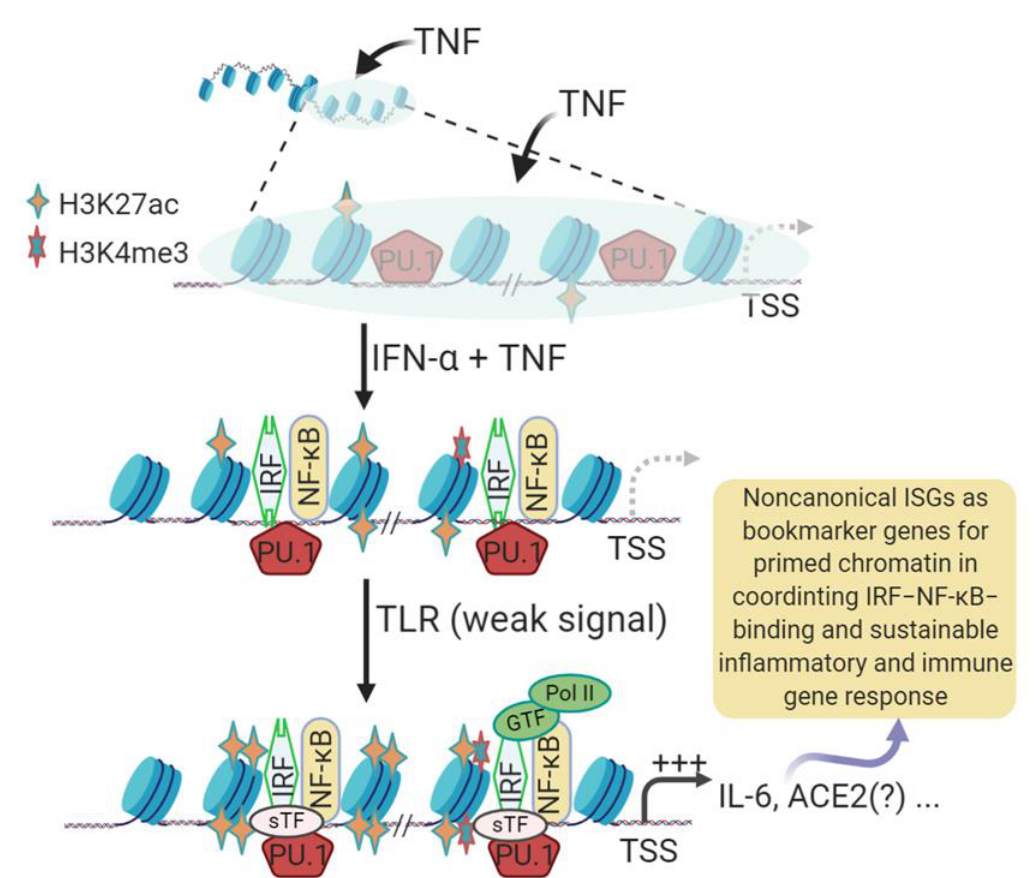
Figure 1. Schematic of epigenetic regulation and interferon (IFN) signaling to coordinate induction of non-canonical IFN-stimulated genes (non-ISGs). Stimulation of lung macrophages and epithelial cells with tumor necrosis factor (TNF) induces transient expression of TNF-target genes encoding inflammatory mediators, such as IL6 and TNF, followed by an insensitive state in which signaling responses to TLR ligands are strongly suppressed, and chromatin is not activated (depicted by a grey shade). This transient suppression state can be activated by a co-stimulation with TNF plus IFN- α and results in an increase in positive histone markers (mostly H3K4me3 and H3K27ac) and chromatin accessibility, which further coordinate binding of IRFs and NF- κ B transcription factors and lead to non-ISG marker gene (such as IL-6) expression. Many inflammatory genes, including angiotensin converting enzyme 2 (ACE2), can be among these genes, which are bookmarked with primed chromatin and subsequently exhibit a robust transcriptional response even to very weak proximal TLR-induced signals, which may comprise a critical factor in the exacerbation of pulmonary inflammatory and COVID-19 syndrome. Adapted and redrawn from Barrat et al. (2019) [51]. Abbreviations: ac, acetyl; me, methylation; Pol, polymerase; PU.1, transcription factor binding to the PU-box, a.k.a SPI1; Non-ISG, non-canonical interferon stimulated genes; GTF, sTF, or TF, general (G), tissue-specific (s) transcription factor (TF); TLR, toll-like receptor; TSS, transcription start site.